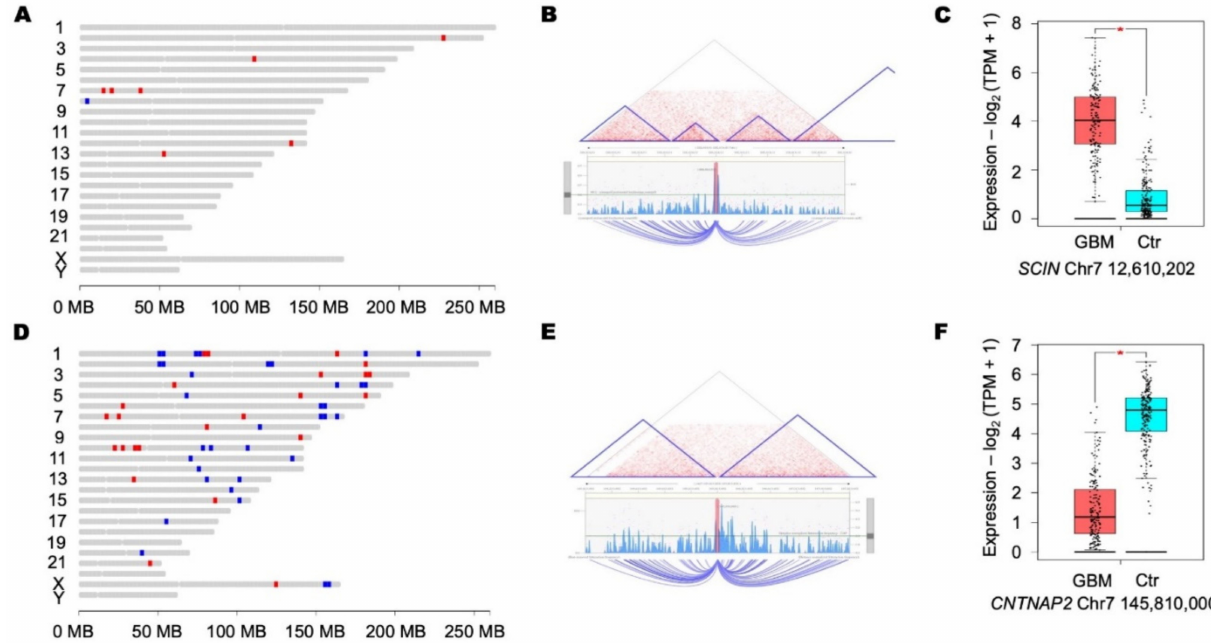
Figure 4. Differential expression of HERVs and neighboring genes in GBM. For the differentially expressed element LTR21A_LTR_ERV1 (chromosome 7: 12,610,202): ( A ) chromosomal plot of differentially expressed genes in spatial proximity; ( B ) potential long-range interaction predicted by 3DIV; and ( C ) the expression level of a long-range interacting gene SCIN in GBM (red, n = 163) and normal brain tissue (blue, n = 207). For differentially expressed MLT1M-int_LTR_ERVL- MaLR element (chromosome 7: 145,810,000): ( D ) chromosomal plot of differentially expressed genes in spatial proximity; ( E ) potential long-range interaction predicted by 3DIV; and ( F ) the expression level of CNTNAP2 , identified through long-range interaction, in GBM (red, n = 163) and normal brain tissue (blue, n = 207). In ( C , F ), the y-axis represents the normalized gene expression level (log 2 (TPM + 1)). * means the significant differentially expressed element between GBM and normal